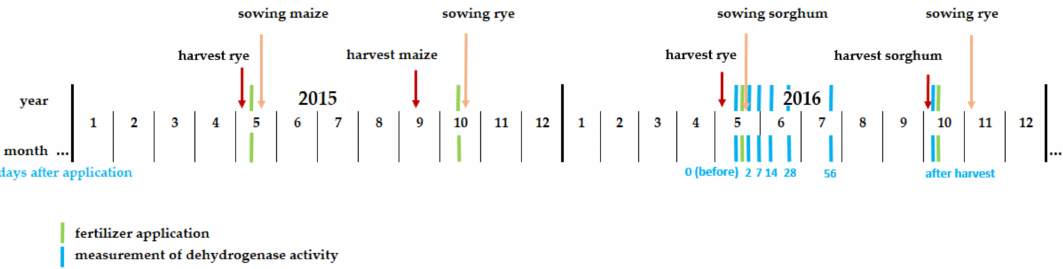
Figure 2. Dates of sowing, harvest, fertilizer application, and dehydrogenase activity measurements in the field trial in 2015 and 2016.